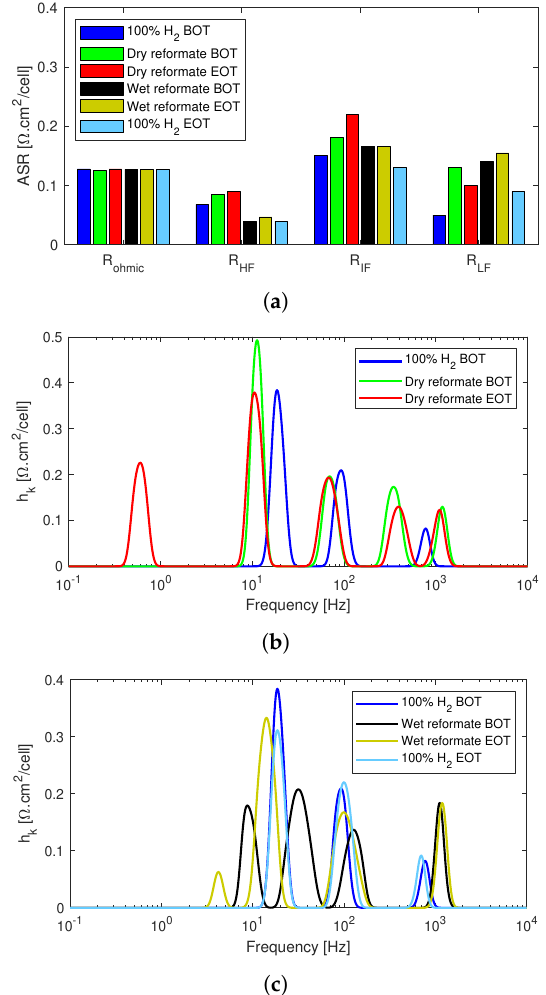
Figure 9. EIS data analysis of the poisoning effects of reformate impurities in the anode feed of the pre-doped MEA-based HT-PEMFC stack. ( a ) Equivalent circuit model fitted resistance data. ( b ) DRT analysis of dry reformate. ( c ) DRT analysis of wet